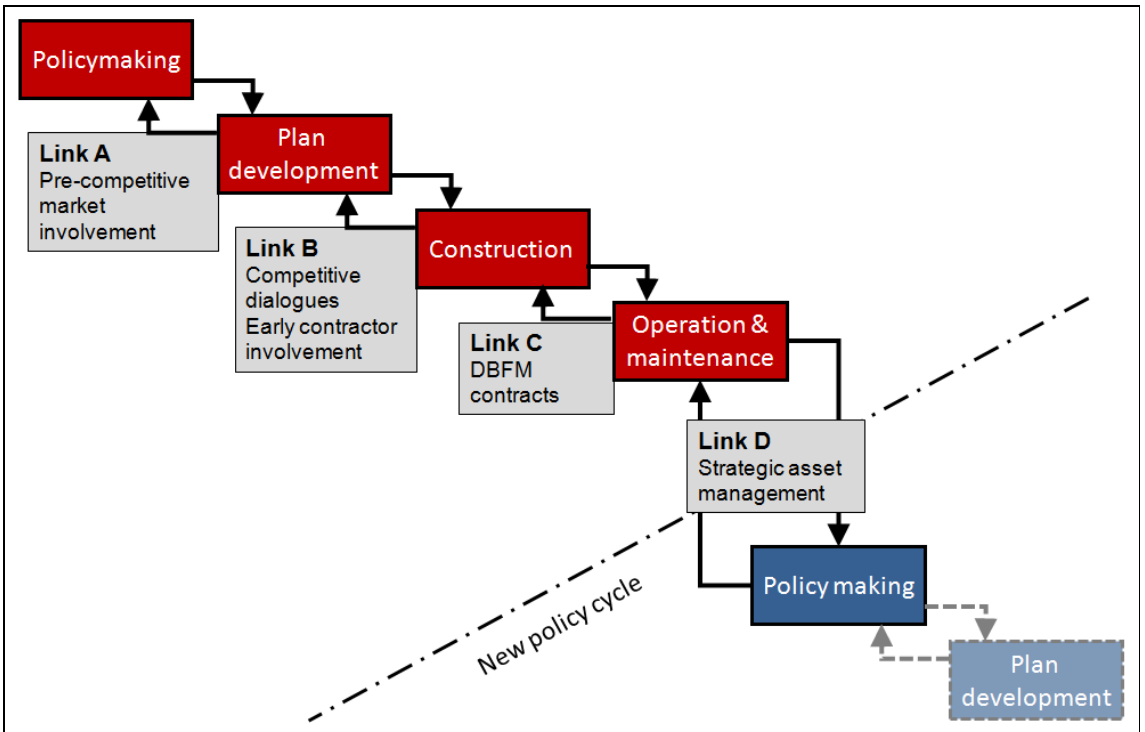
Figure 1: Lifecycle integration links investigated in